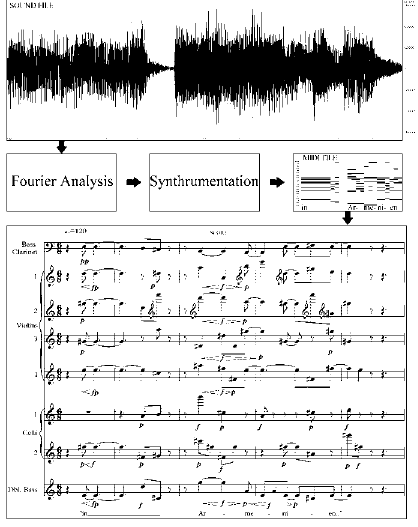
Figure 4: Excerpt “in Armenien” from Im Januar am Nil in five synthrumentation